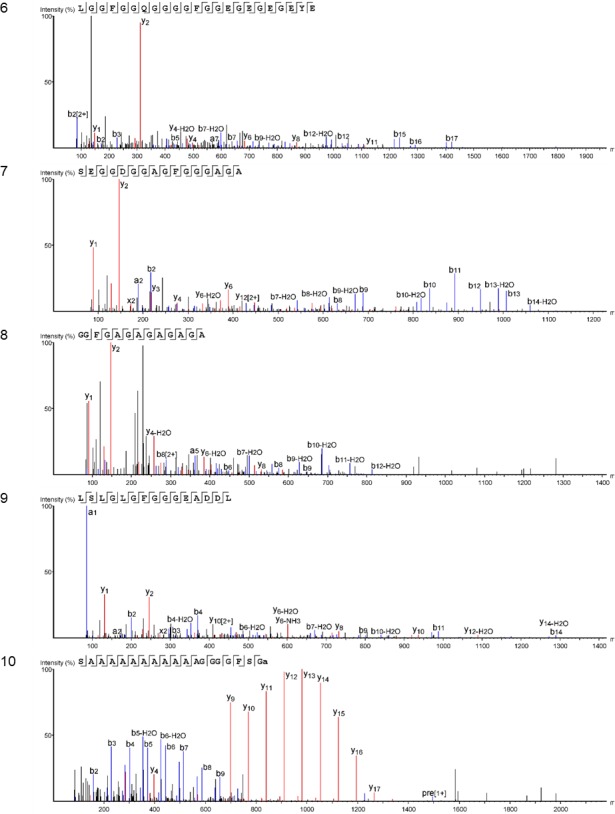
Product ion spectra [6 - 10] supporting the coverage of protein Hic74 identified in Unio pictorum.